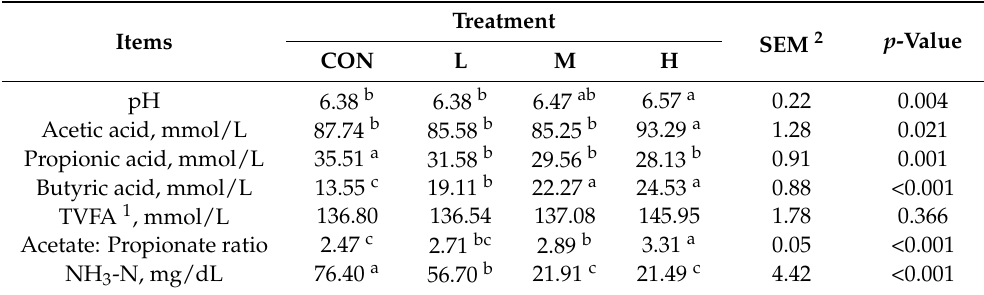
Table 4. Effects of replacing 0 (CON group), 20 (L group), 40 (M group) and 60% (H group) of maize silage with mulberry silage on lambs’ rumen fermentation characteristics.